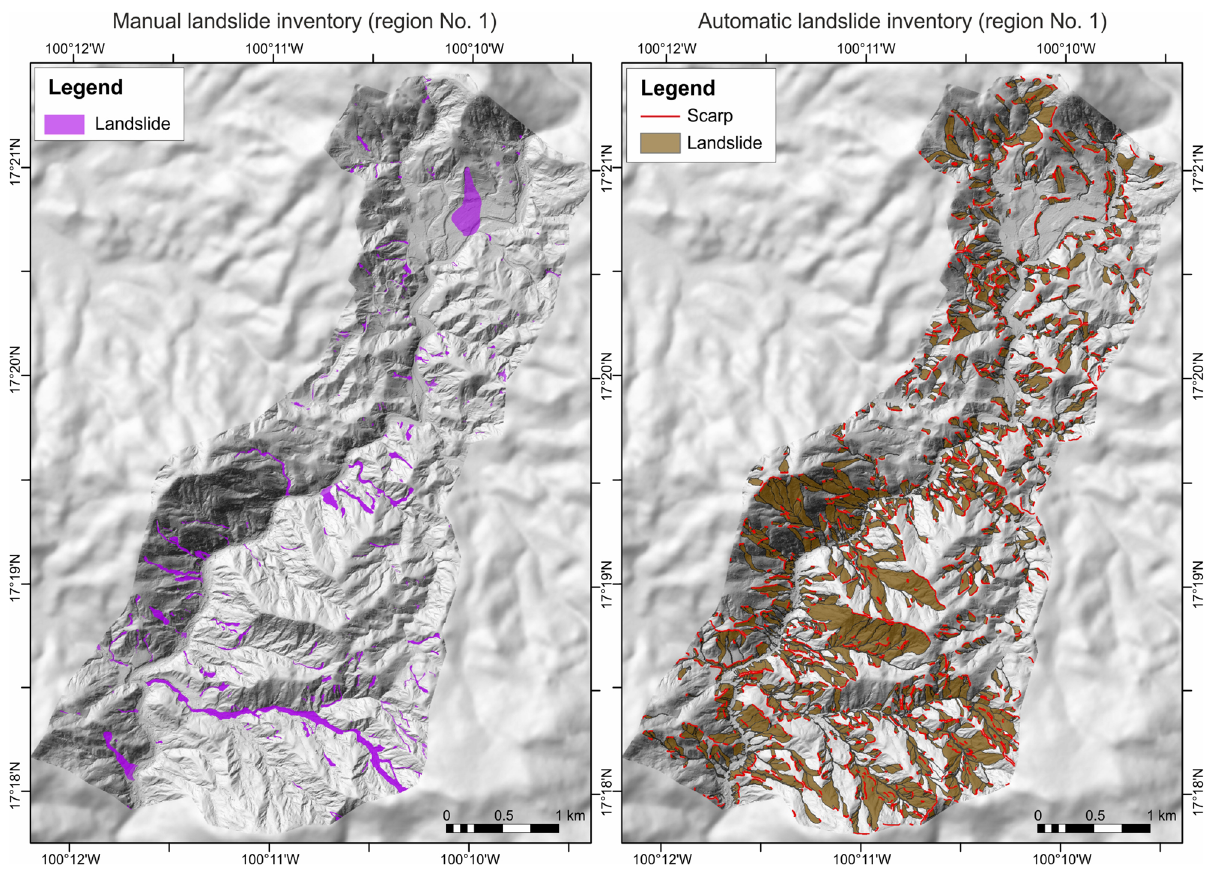
Figure 2. Landslides identified in region No. 1 using two approaches, including manual mapping using satellite images and automatic identification of landslide morphology employing CCM algorithm on shaded relief of LIDAR derived DTMs. Maps were generated using ArcMap 10.2.2 software, copyright and licensed by ESRI (http:// deskt op. arcgis. com/ en/). The final layout was created in ArcMap 10.2.2 (http:// deskt op. arcgis. com/ en/) and CorelDRAW 2018 (https:// www. corel draw. com/